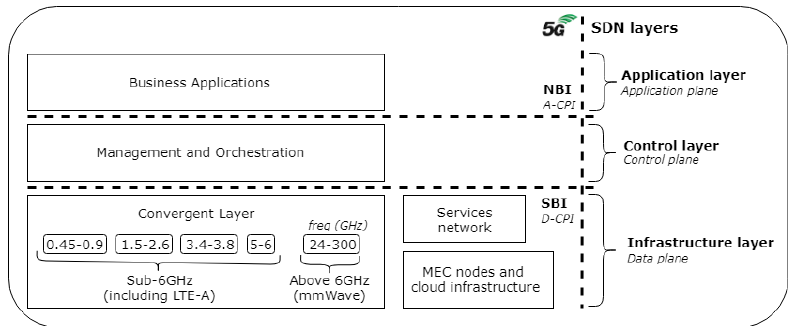
Figure 2. 5G integration with SDN.